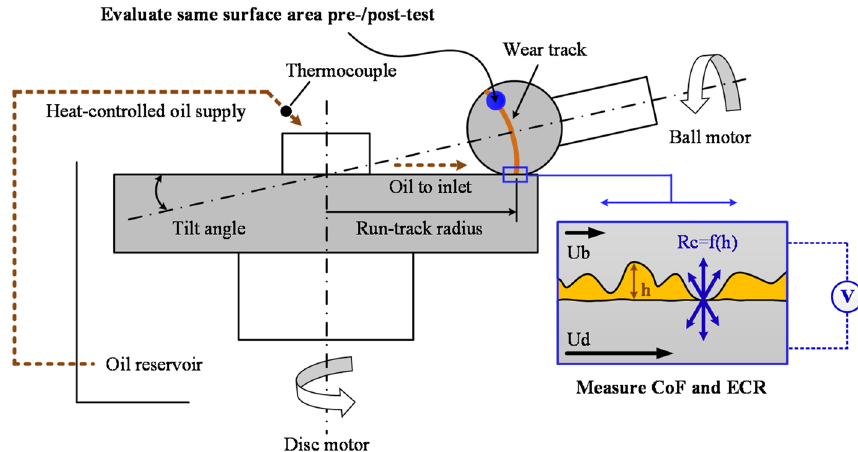
Figure 8. The most essential components of the experimental setup and procedure (not to scale).